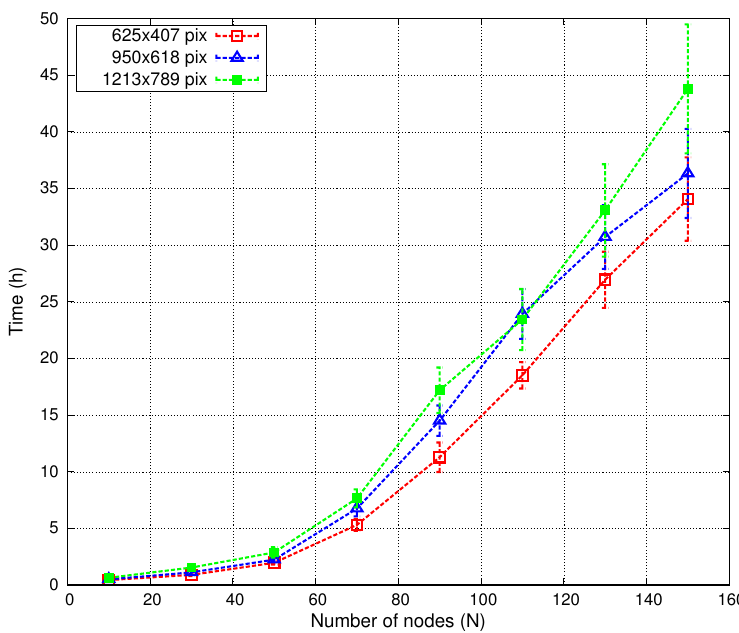
Figure 10. Convergence time versus number of nodes ( N ) and scenario size.